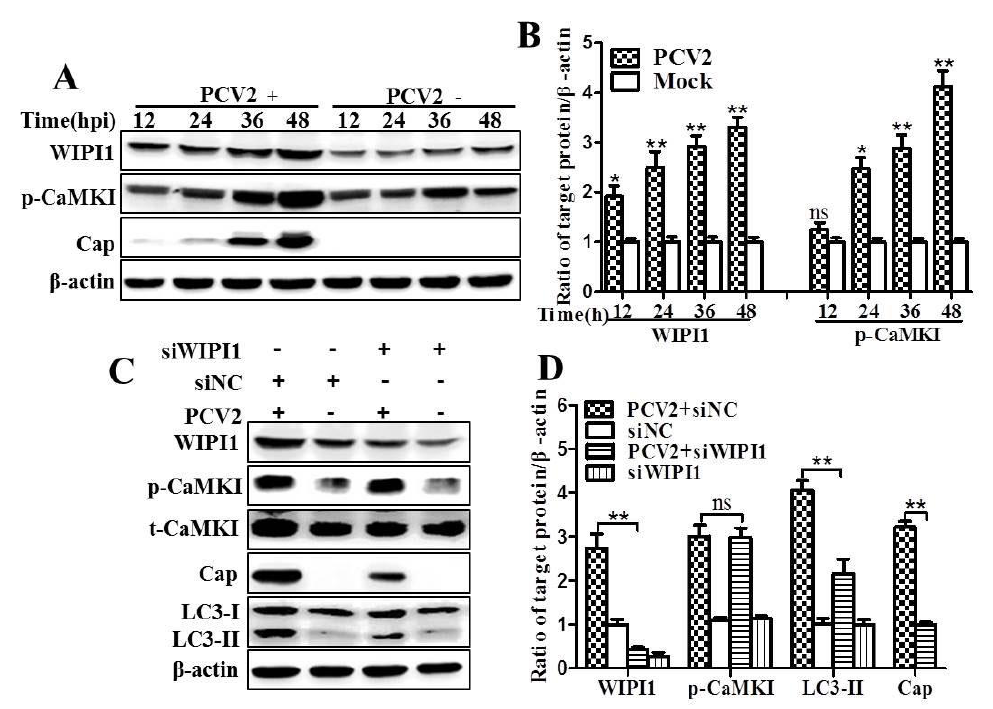
Figure 3. PCV2 infection upregulated Trp-Asp (WD) repeat domain phosphoinositide-interacting protein 1 (WIPI1). Knock-down of WIPI1 downregulated LC3-II and Cap protein without affecting CaMKI. PK-15 cells were infected with PCV2 (MOI ≈ 1) in the presence of siRNA targeting WIPI1 (siWIPI1) for the indicated hpi and the whole cell lysates were subjected to Western blotting. ( A ) Representative images of Western blotting for target proteins of cells; ( B ) ratios of WIPI1, p-CaMKI to β-actin; ( C ) representative images of Western blotting for the target proteins of PCV2-infected cells treated with siWIPI1 at 36 hpi; and ( D ) ratios of WIPI1, p-CaMKI, Cap, and LC3-II to β-actin. Ratios of targeted proteins to β-actin were normalized to mock infection set at 1.0. Scrambled, negative control RNA (siNC) was included. Data are reported as the mean ± SEM of three independent experiments (ns p > 0.05; * p < 0.05; and ** p < 0.01).